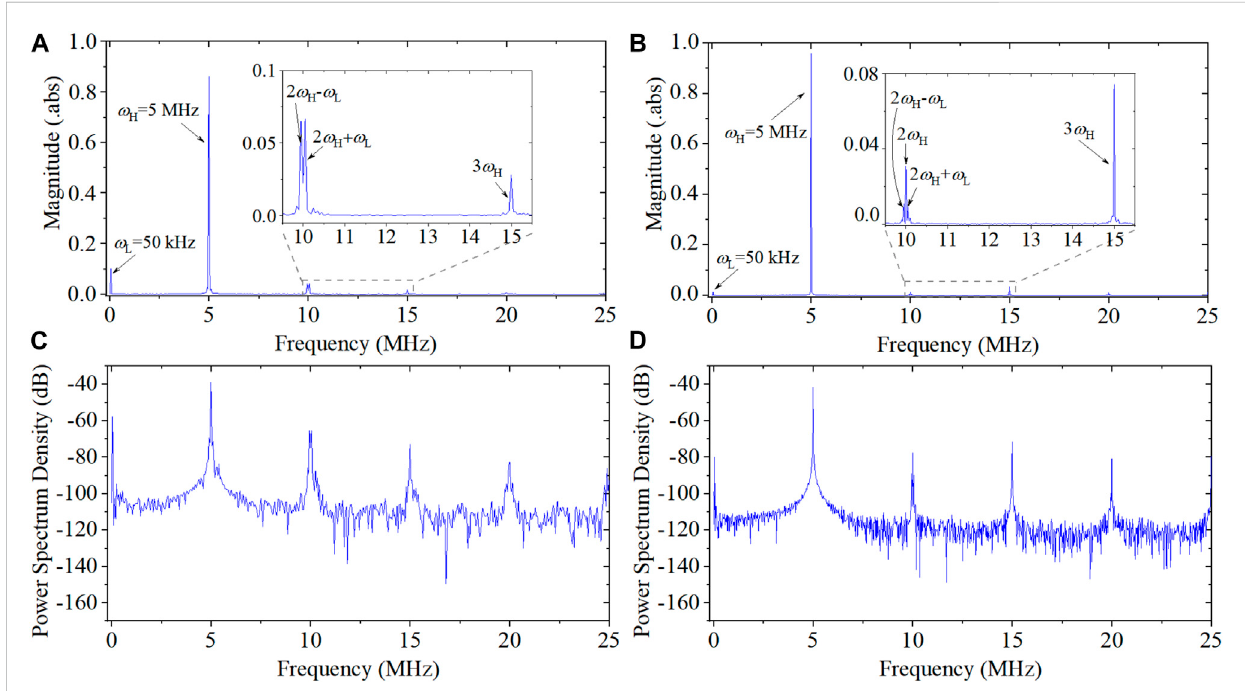
FIGURE 9 Typical fast Fourier transform (FFT) spectra and power spectral densities of the dual-DBD discharge current in the LF-dominant mode with V L = 1300 V/ V H = 350 V, (A, C) and the DF-comparable mode with V L = 550 V/ V H = 350 V, (B, D) .